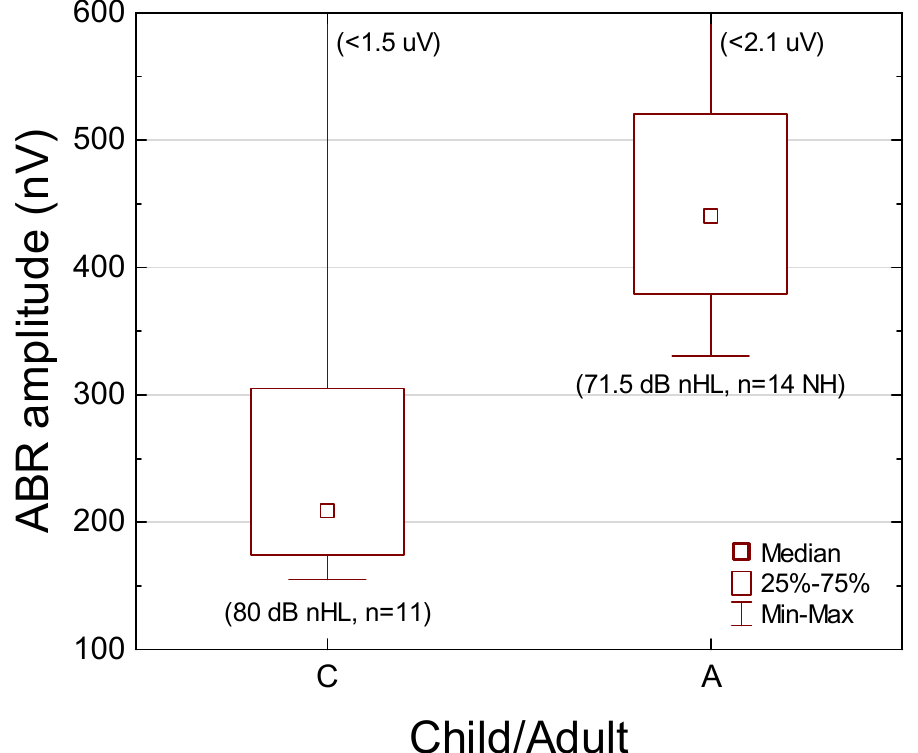
Figure 5. Comparison of click-evoked auditory brainstem response (ABR) RMS amplitudes (entire signal, ρ = 0.70) for the 11 hearing-impaired children (C, better ear) obtained at 80 dB nHL and 14 normal-hearing (NH) young adults (A, average between left and right ears) at 71.5 dB nHL [23]. Box-plots show median, quartiles, and span. Although the stimulus level was higher in the hearing- impaired children, the entire ABR RMS amplitude was significantly lower than in the NH young adults ( p < 0.002, Mann–Whitney U test). Median ABR RMS amplitude in the children was 210 nV (at 80 dB nHL) and 440 nV in the adults (at 71.5 dB nHL).